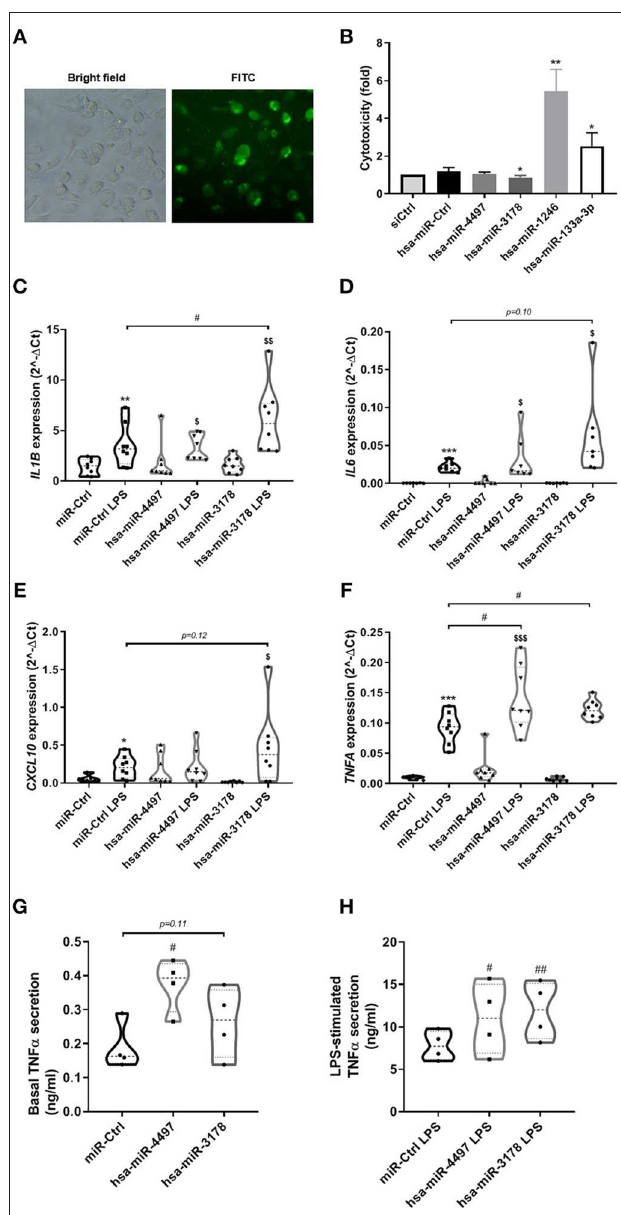
FIGURE 3 | hsa-miR-4497 and hsa-miR-3178 augments LPS-induced TNF α expression and secretion. Fluorescence microscopy of human THP-1 cells transfected with siGLO. (B) THP-1 cells transfected with negative control miRNA (miR-Ctrl) or hsa-miR-4497, hsa-miR-1246, hsa-miR-133a-3p, and hsa-miR-3178 were subject to cytotoxicity assay 2 days post transfection to determine cell viability. Data are means ± SEM of n = 5. (C–F) Gene expression in THP-1 cells transfected as in (B) and exposed to 5ng/ml LPS for 3h was measured by realtime PCR and normalized to that of ACTB . Data are means ± SEM of n = 8. *, **, *** p < 0.05, 0.01, 0.001, respectively, vs. miR-Ctrl. $ , $$ p < 0.05, 0.01, respectively, vs. hsa-miR-4497 and hsa-miR-3178. # p < 0.05, One-way ANOVA with multiple comparisons (A–F) . Basal (G) and LPS-induced (H) TNF α secretion to the culture medium during 3h from human THP-1 cells transfected with negative control miRNA (miR-Ctrl) or hsa-miR-4497 and hsa-miR-3178. Data are means ± SEM of n = 4. # p ≤ 0.05, paired t -test (G,H)